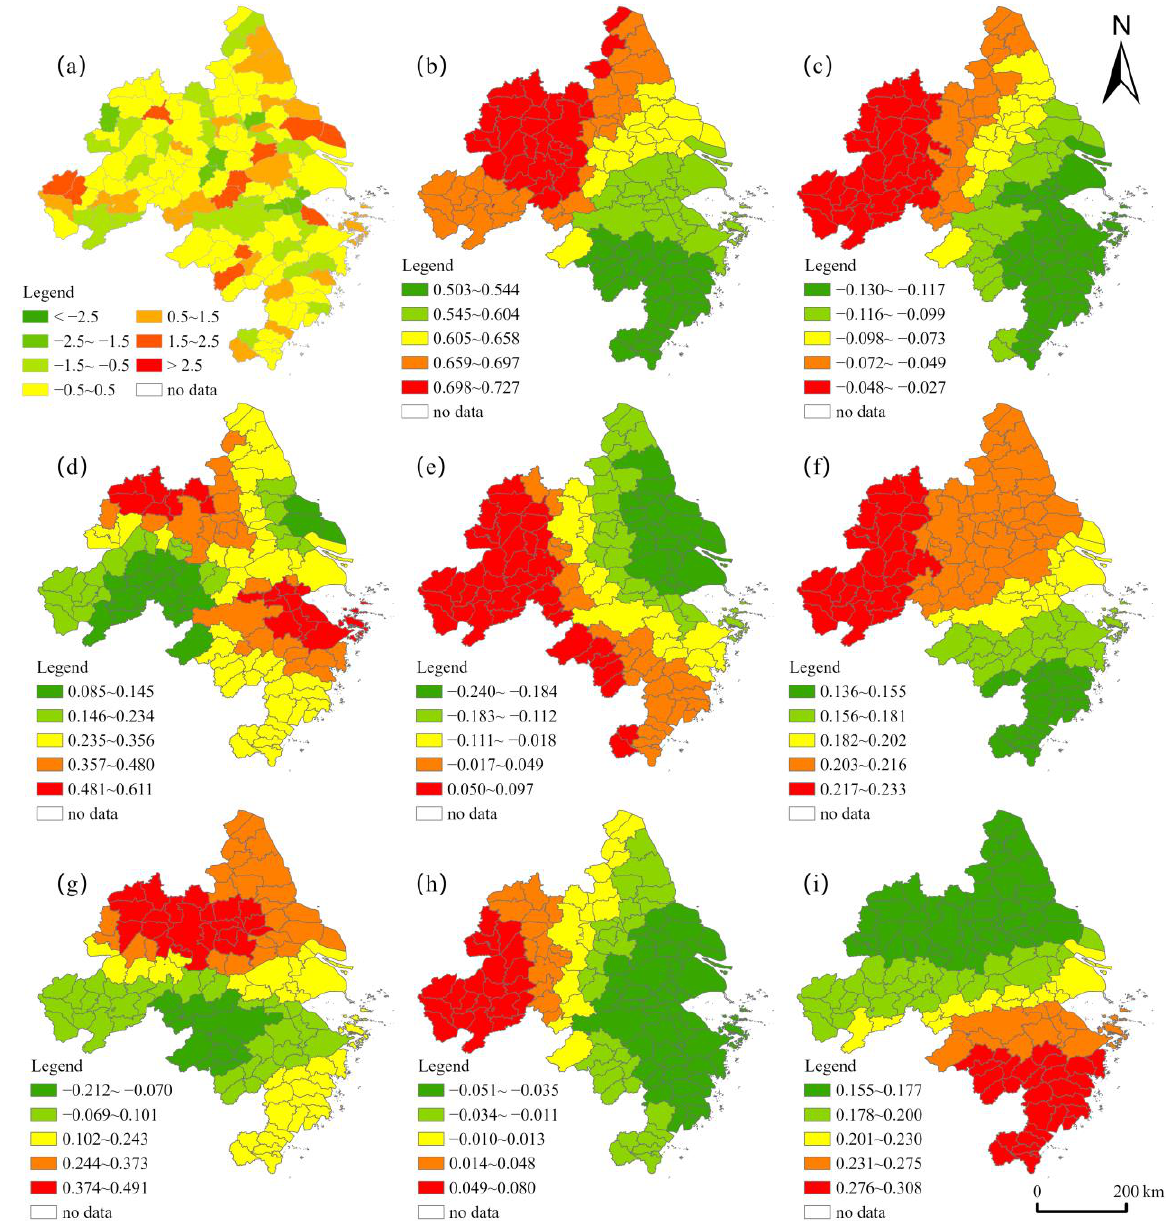
Figure 9. Spatial distribution of standardized residual and regression coefficients of driving factors for LUR based on the MGWR model in the Yangtze River Delta urban agglomeration in 2020. (a) Standardized residual; (b) per capita GDP; (c) proportion of secondary industry in GDP; (d) fiscal revenue; (e) number of healthcare beds; (f) density of roads; (g) population density; (h) topographic relief; (i) annual precipitation.